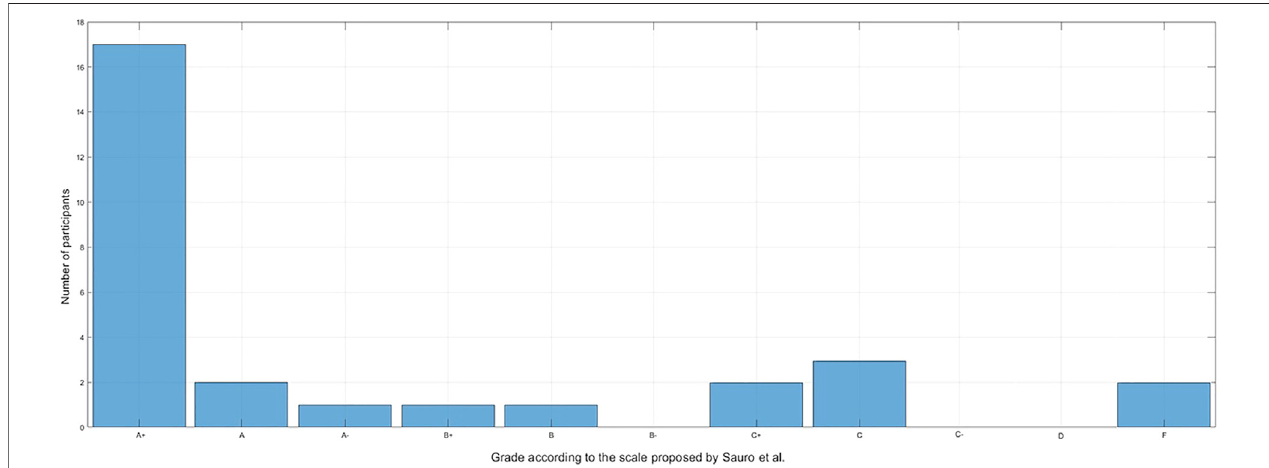
FIGURE 6 | The SUS grades distribution, according to rating scale proposed by Sauro (2011), achieved in the usability study.